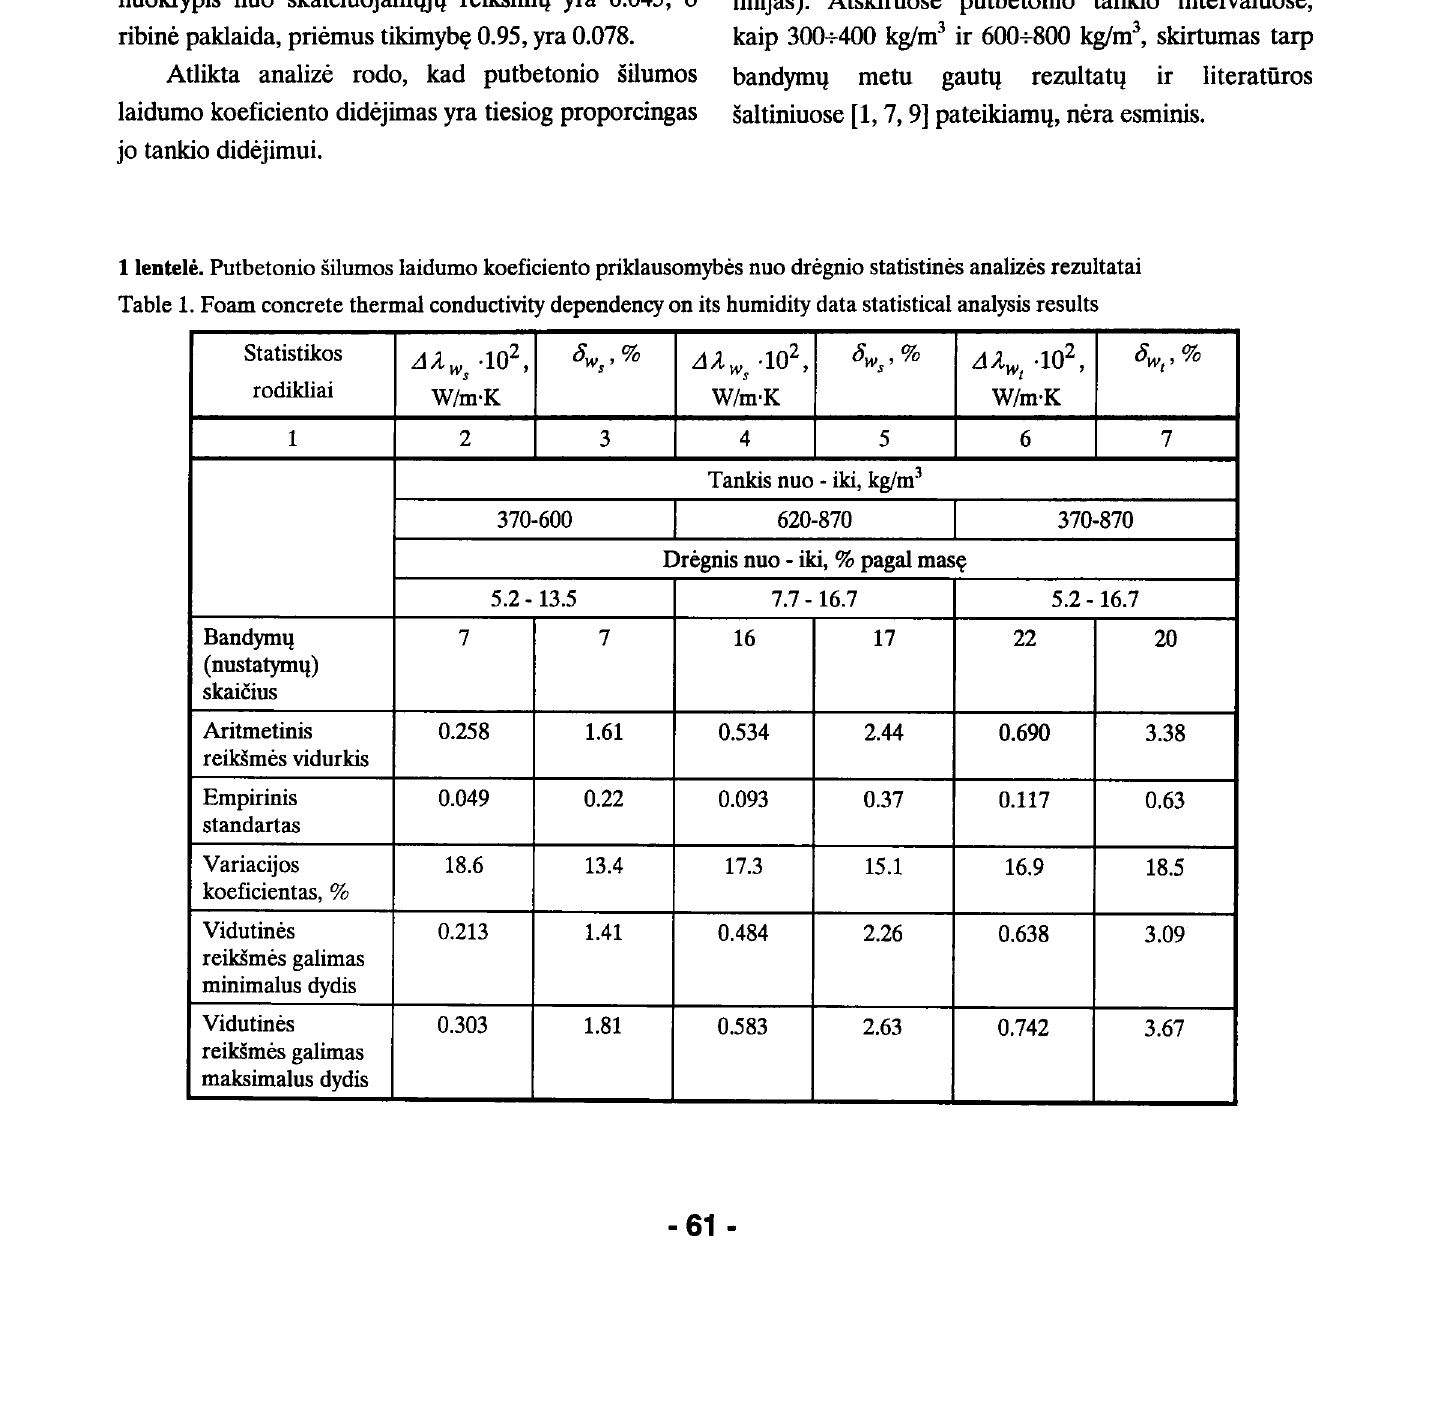
Table 1. Foam concrete thermal conductivity dependency on its humidity data statistical analysis results